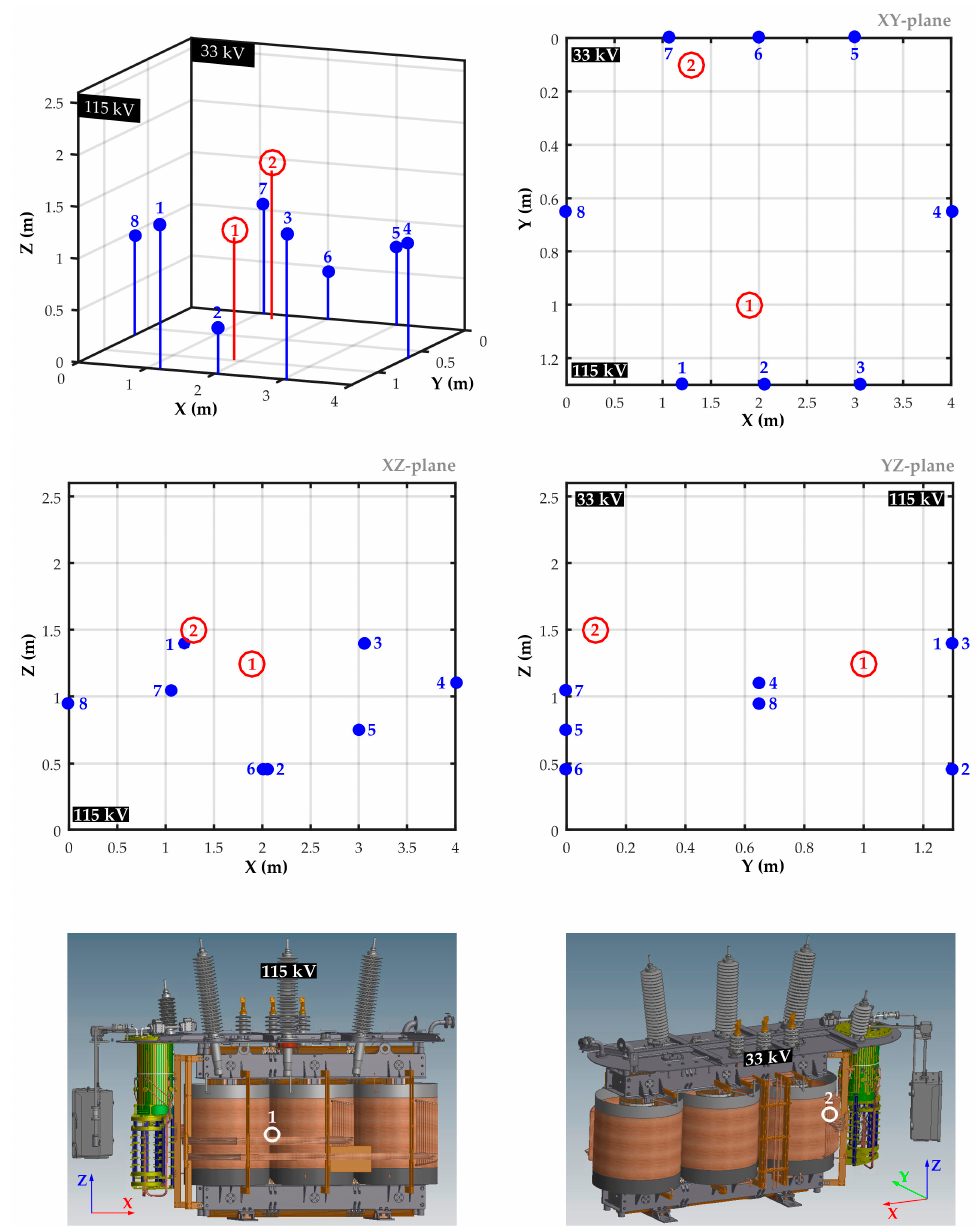
Figure 29. Graphic presentation of the localization results of two partial discharges sources by the trilateration technique and the distribution of the eight AE sensors (blue dots).